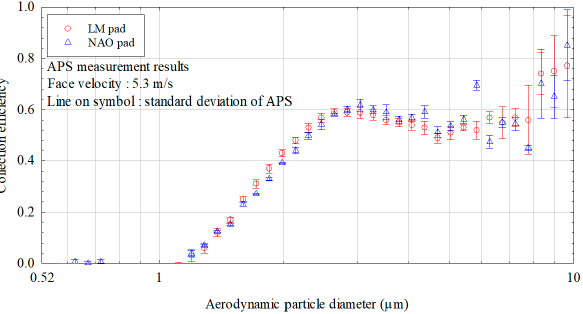
Figure 7. Particle collection efficiency size distributions for the inertial separator.